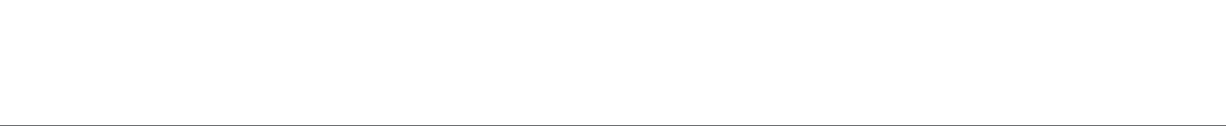
Frontiers in Environmental Science |